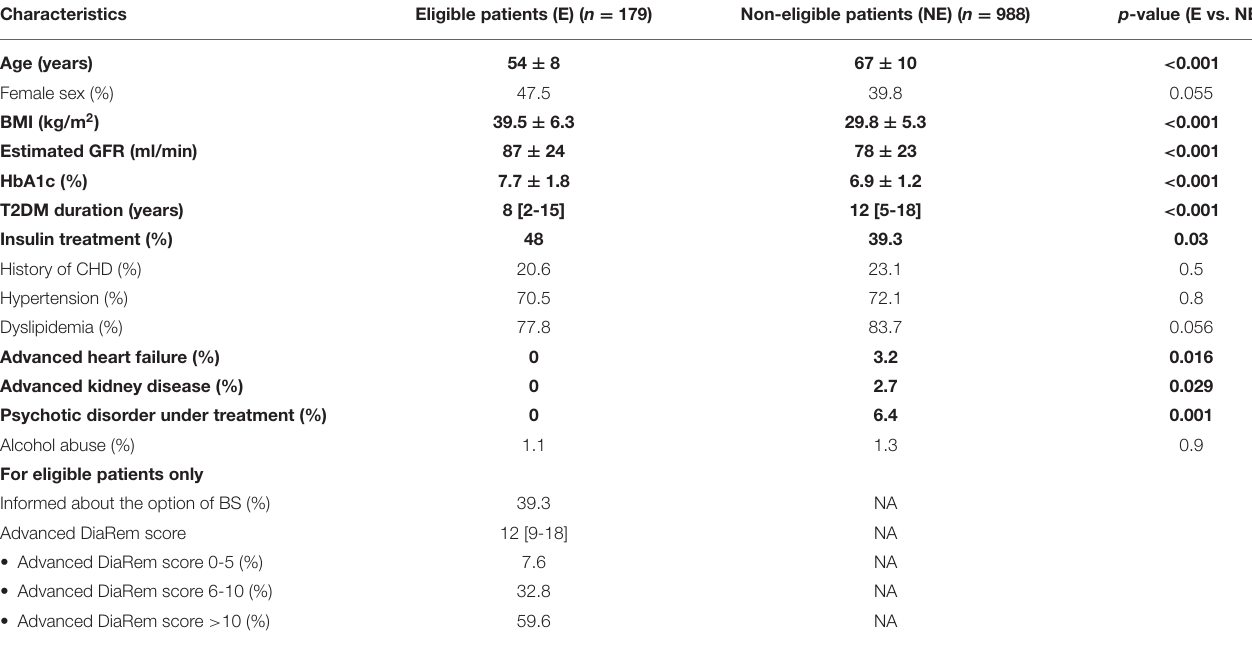
TABLE 2 | Comparison of demographic and clinical characteristics between eligible (E) and non-eligible (NE) diabetic patients for metabolic surgery according to DSS-II eligibility criteria.